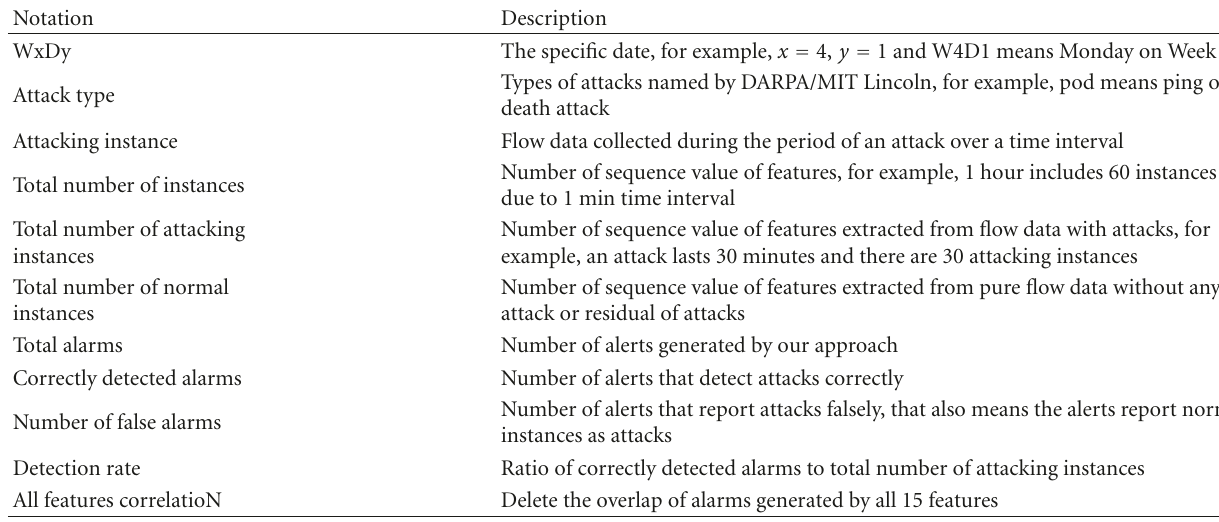
Table 2: List of notations used in experimental evaluation.